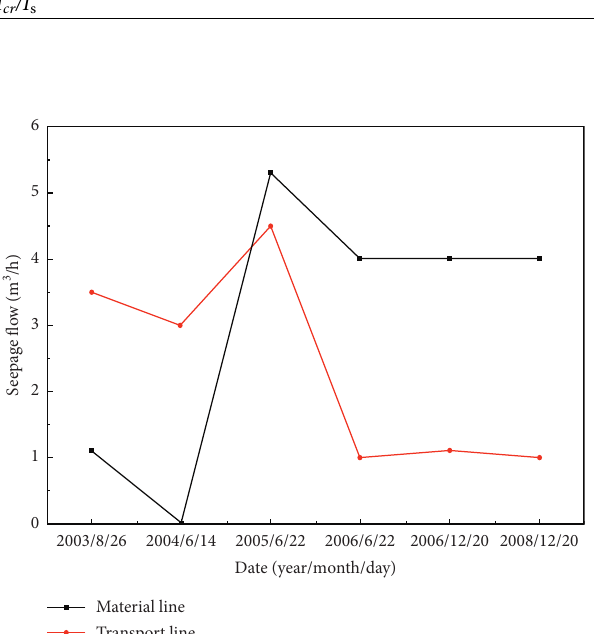
Figure 6: Changes in water pressure with time of bulkheads at Panel No.